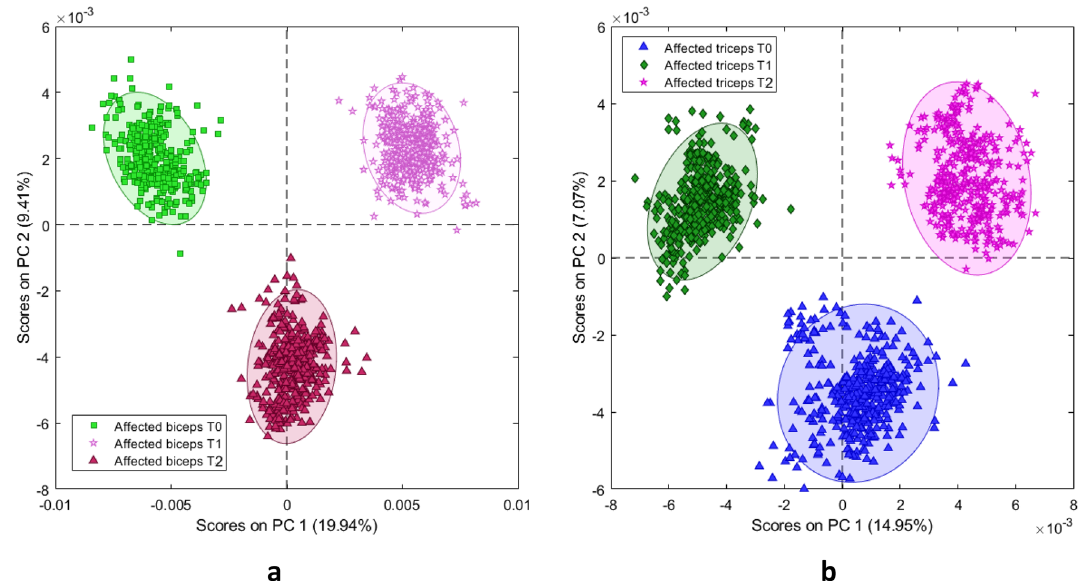
Figure 5. Principal component analysis score plots for (a) affected biceps spectra and (b) affected triceps spectra at T0 vs. T1 vs.